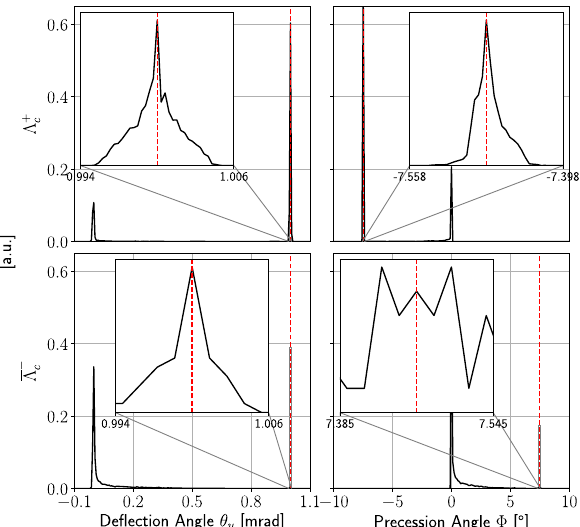
Fig. 6 Distributions of the trajectory deflection angle and spin preces- sion angle for (top) Λ + c and (bottom) Λ − c baryons of 1TeV / c momen- tum interacting with a 1cm long crystal uniformly bent along the ( 110 ) plane at 1mrad angle